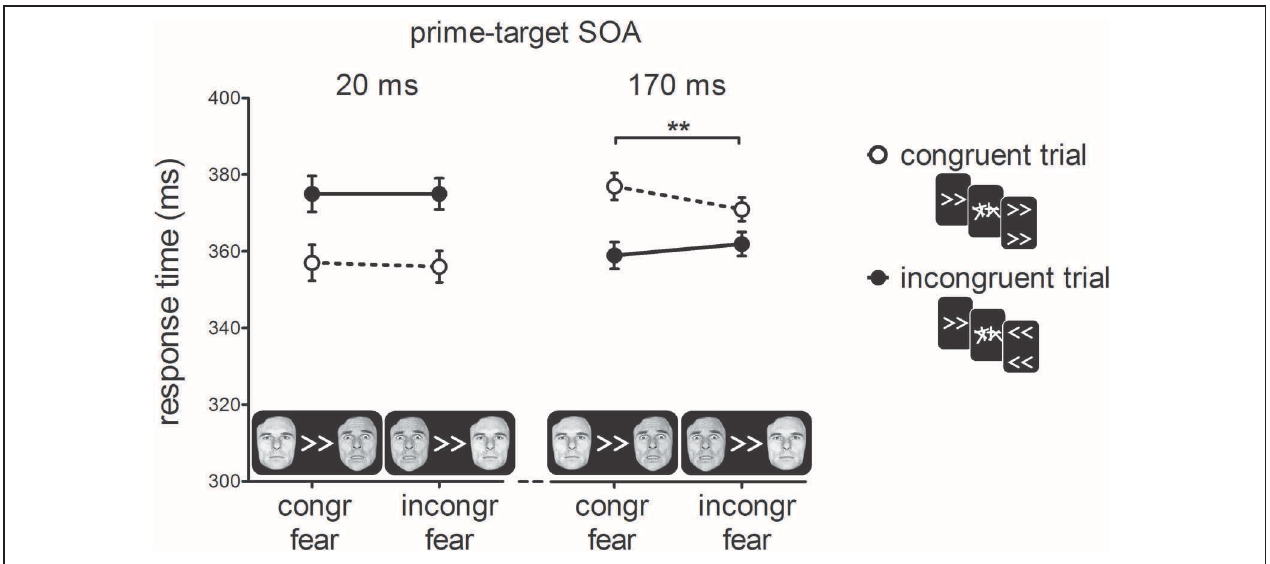
FIGURE 4 | Response times in milliseconds (ms) for the experimental conditions in Experiment 2. For congruent fear cues, the fearful face was presented on the same side as the direction of the prime, whereas for